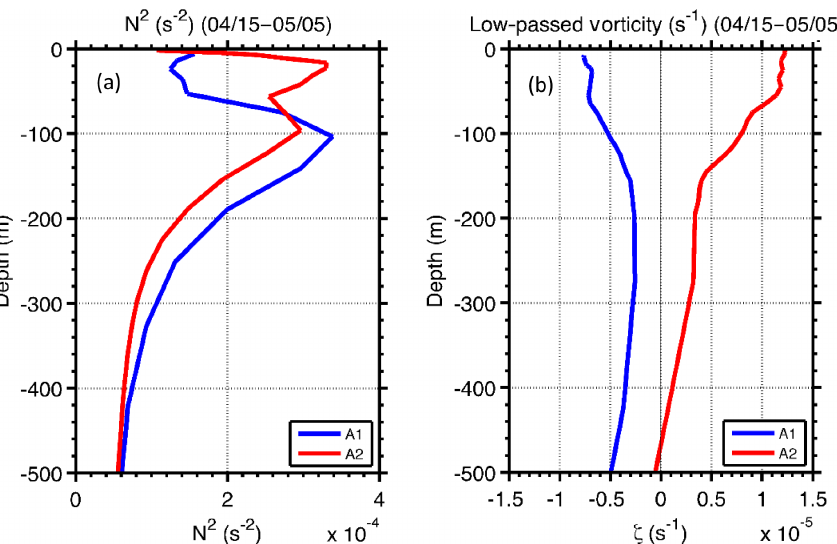
Figure 10. Time-averaged (a) N 2 (s − 2 ) and (b) low-passed (3d) vorticity from 15 April to 5 May at locations A1 (red) and A2